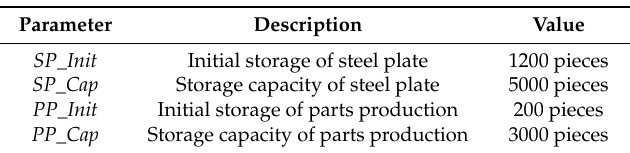
Table 4. Parameters for products.